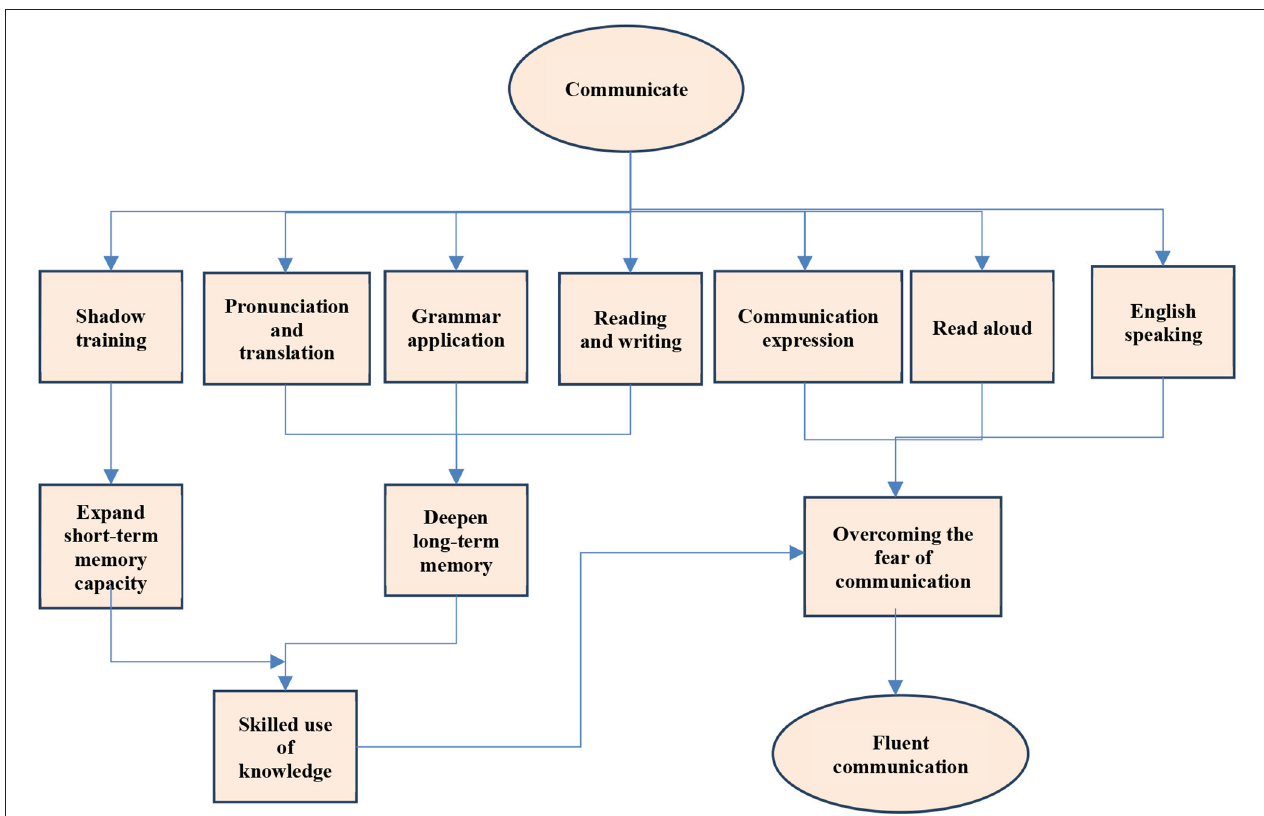
FIGURE 5 | The model of English communication